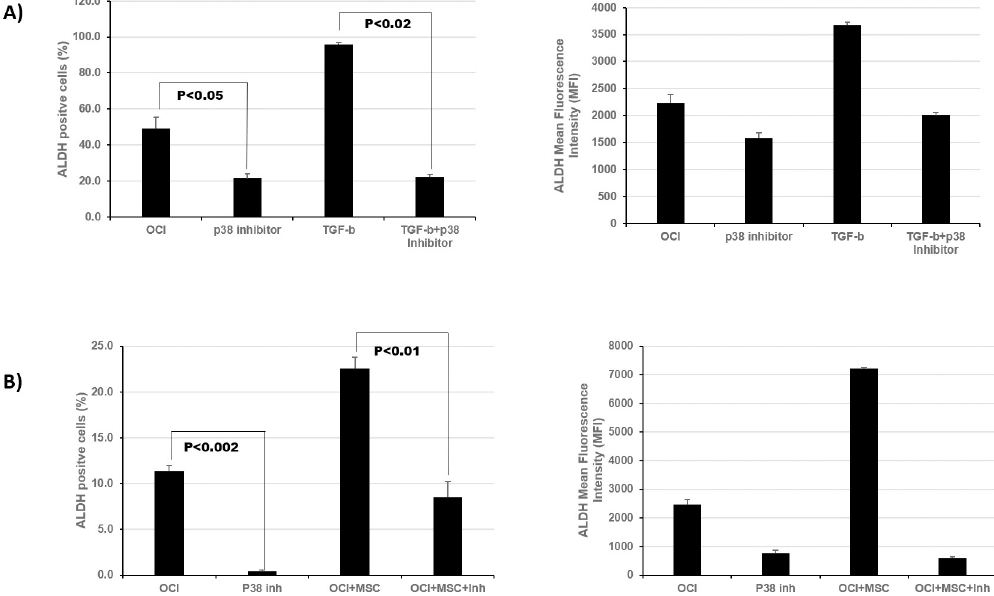
Fig 5. p38 MAPK inhibitor decreases ALDH2 expression in AML cells in the presence of TGF- β 1 or stromal cells. (A) . OCI-AML3 cells were treated with the p38 MAPK inhibitor SB-23580 (5 μ M) in the presence or absence of recombinant TGF- β 1 (5 ng/mL). ALDH activity was measured by flow cytometry using ALDEFLUOR 1 assay in comparison to untreated controls. (B ) OCI-AML3 cells were cultured with or without BM-MSCs and treated with p38 MAPK as in A. ALDH activity was measured in treated cells in comparison with untreated controls. Data are plotted as mean values with error bars representing standard error via one-way ANOVA with Tukey’s HSD post-hoc test (N = 3).